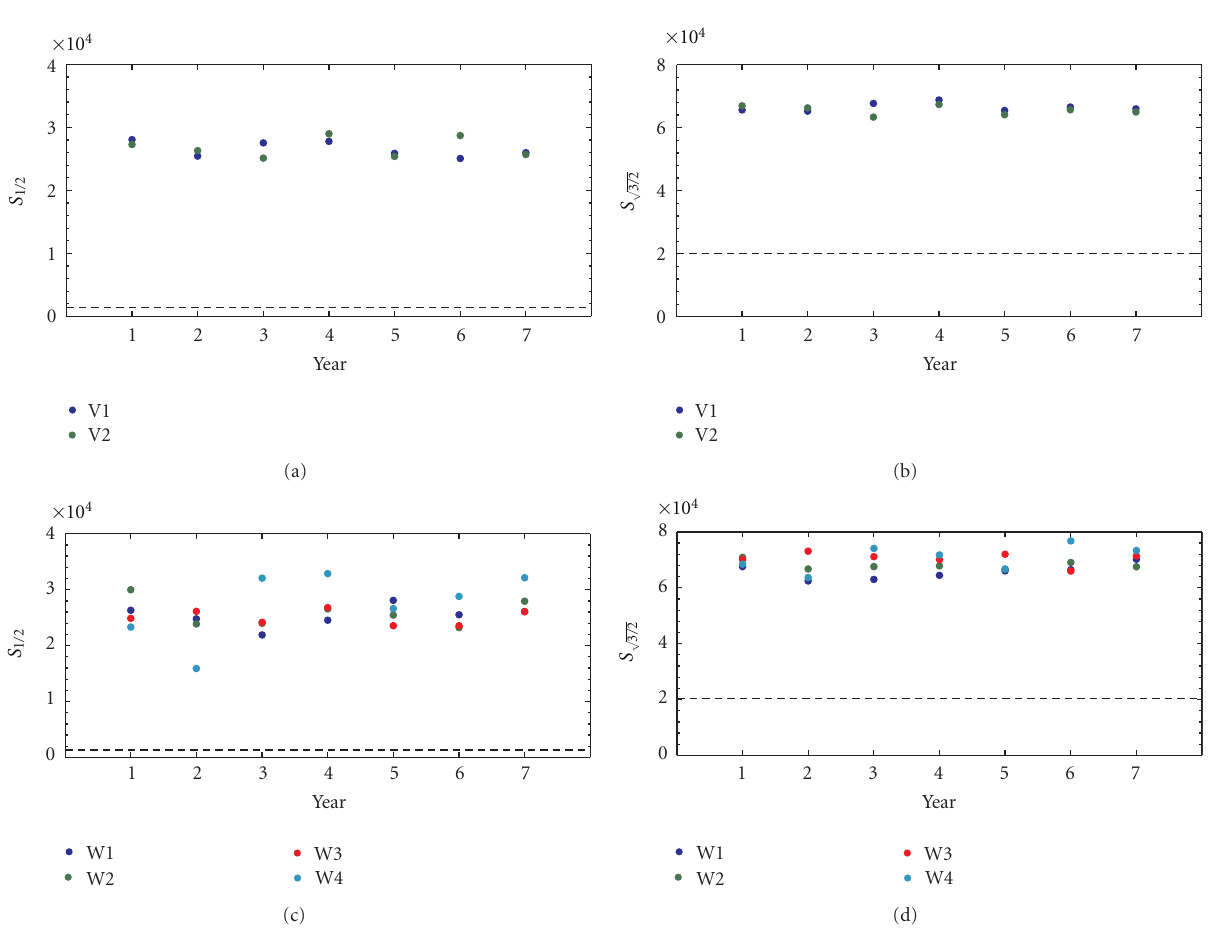
60 ◦ ≤ θ ≤ 120 ◦ , the angular correlation has negative values, while the deviation αε ( − F ( θ ) + G ( θ )) is positive. At